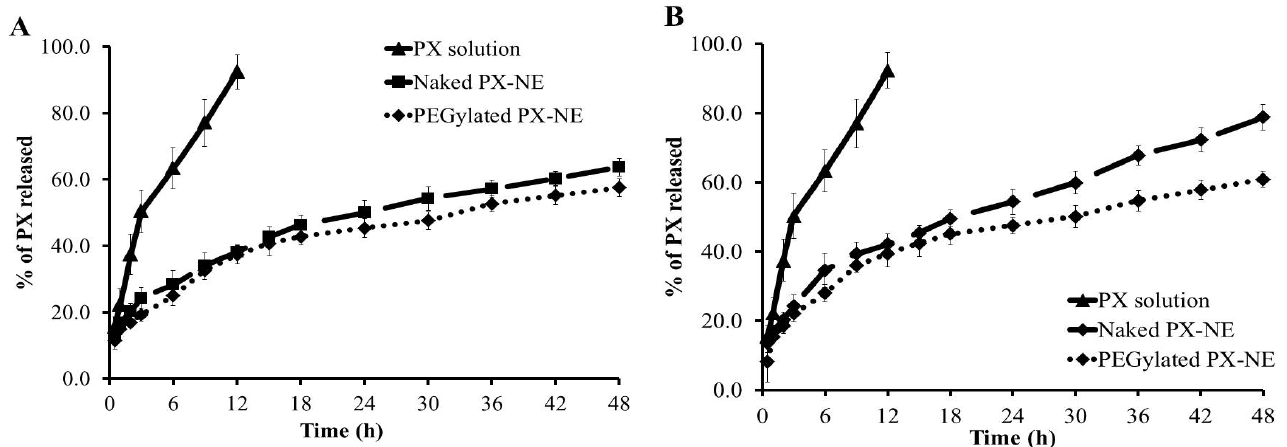
Figure 8. Profile of PX in vitro release from PX solution, PEGylated, and naked NEs ( A ) without serum incubation; ( B ) after serum incubation. Results are expressed as the mean ± SD. n = 3.